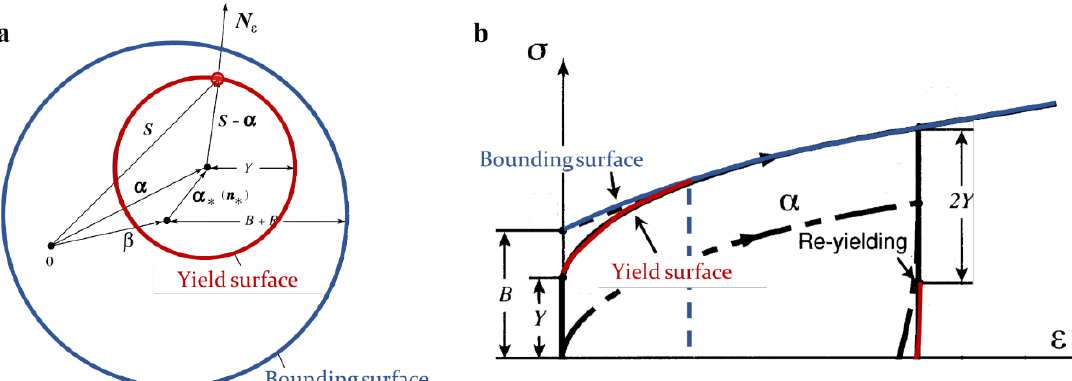
Figure 8. Schematic of the YU 02 model’s description of the Bauschinger effect with high nonlinearity: